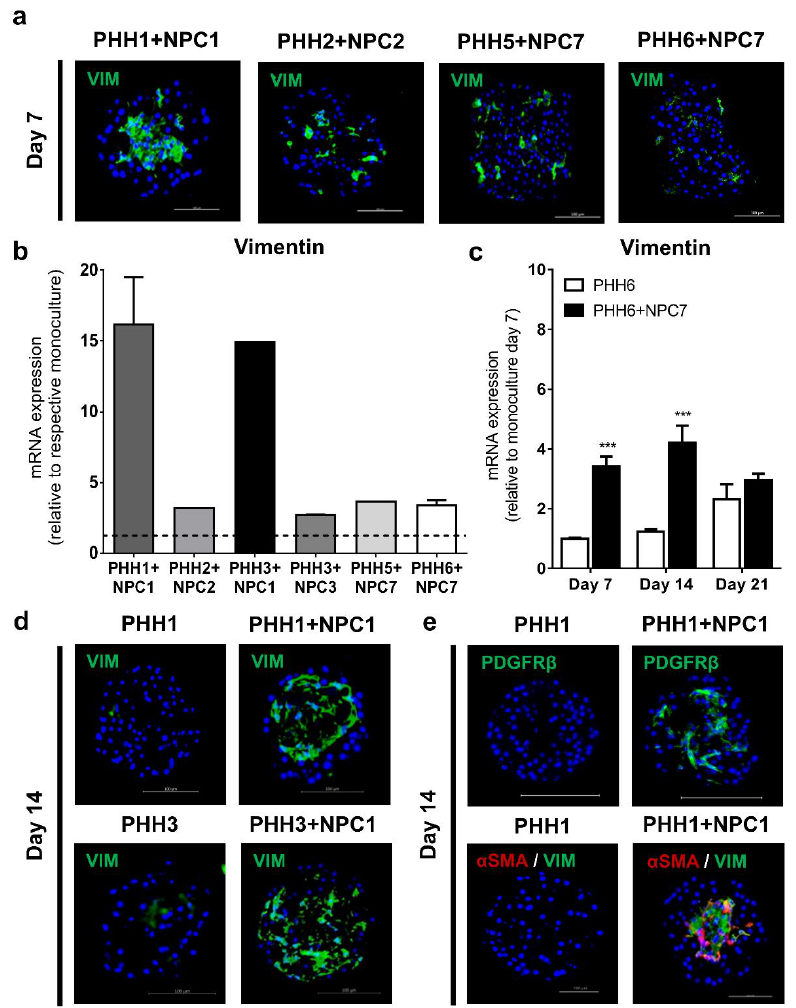
Figure 2. Spheroid co-cultures express markers of NPC populations. Co-cultures stained with vimentin show dispersed localization of HSCs in different spheroid co-cultures at day 7 ( a ). The mRNA expression of vimentin was very high in co-cultures containing NPCs from donor 1 ( b ). Incorporation of vimentin-expressing cells originated from the NPC fraction with the increase in vimentin mRNA expression from the same donor combination (n = 6) being highly reproducible over the time course ( c ). Incorporation of NPCs from donor 1 was independent of the PHH donor ( d ). The presence of HSCs was further validated with the use of PDGFRβ staining ( e ) and co-staining of vimentin and αSMA on day 14, suggesting an activated HSC phenotype exclusively observed in co-cultures ( e ). VIM: Vimentin, αSMA: alpha-smooth muscle actin. PDGFRβ: platelet-derived growth factor receptor β. *** p < 0.001.